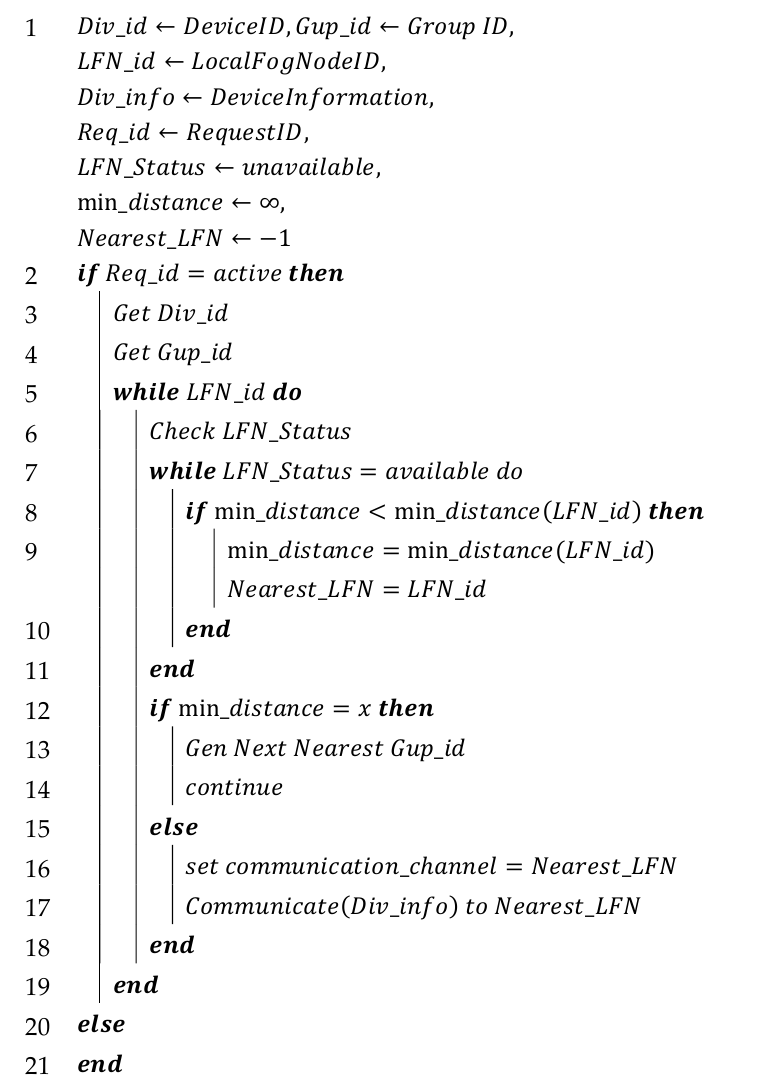
Algorithm 1: To find the nearest available LFN through manageable hub.